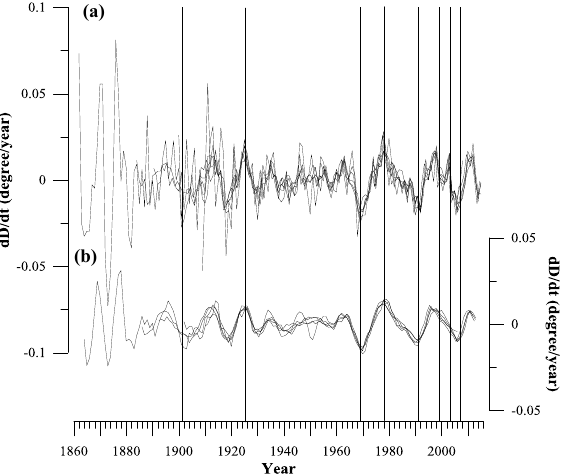
Figure 7. (a) The decadal variation of the first time derivative of declination at the European observatories (cyclical constituent from an HP filtering). (b) The 5-year running average smoothing of the time series plotted in (a) . Vertical lines mark the generally accepted 20th century geomagnetic